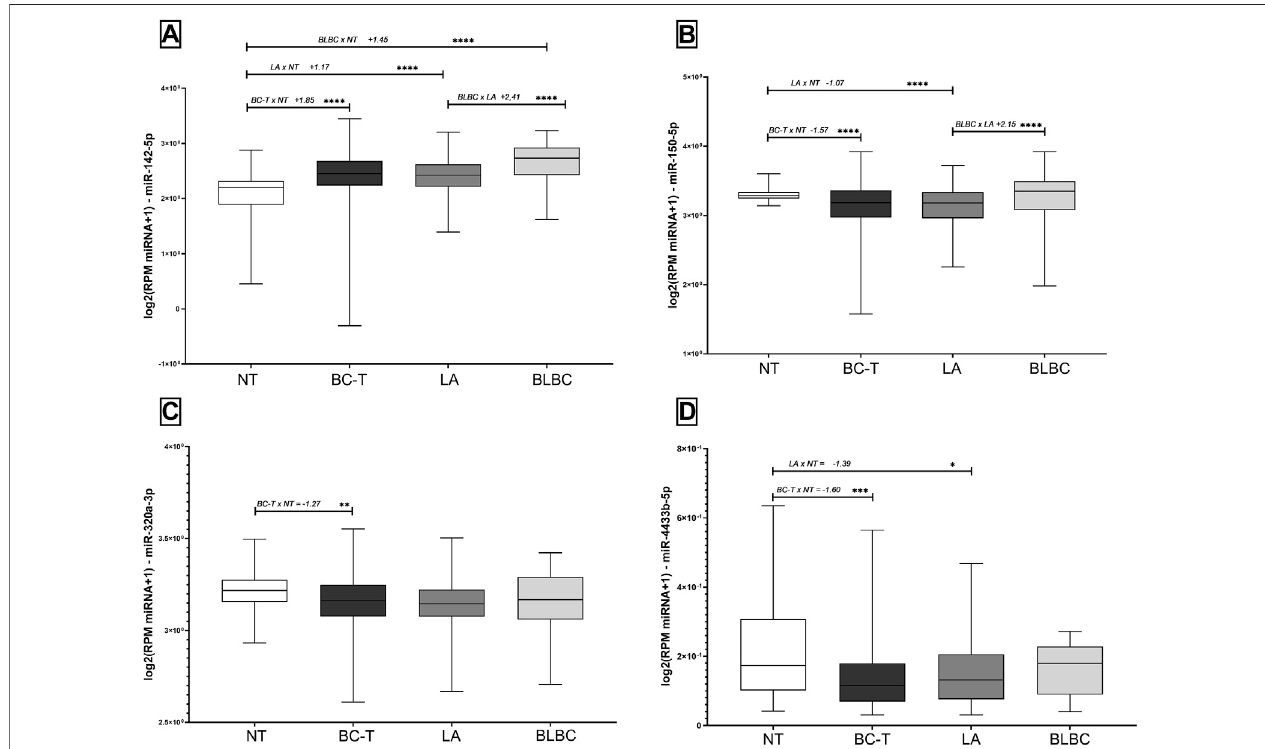
FIGURE 4 | Expression levels of miR-142-5p, miR-150-5p, miR-320a-3p, and miR-4433b-5p in tissue samples according to the TCGA database. Expression levelsof (A) miR-142-5p, (B) miR-150-5p, (C) miR-320a-3p,and (D) miR-4433b-5pinBC-Tandsubtypes(LAandBLBC)andNT.Foldchangebetweenthetwogroups comparedandtheorderofcomparisons wereindicatedbeforetheFCand p values.NT,non-tumorsamples;BC-T,breastcancertissuesamples;LA,luminalA;BLBC, basal-like breast cancer; and FC, fold change. (*) p < 0.01; (**) p = 0.001; (***) p = 0.0001; and (****) p < 0.0001.